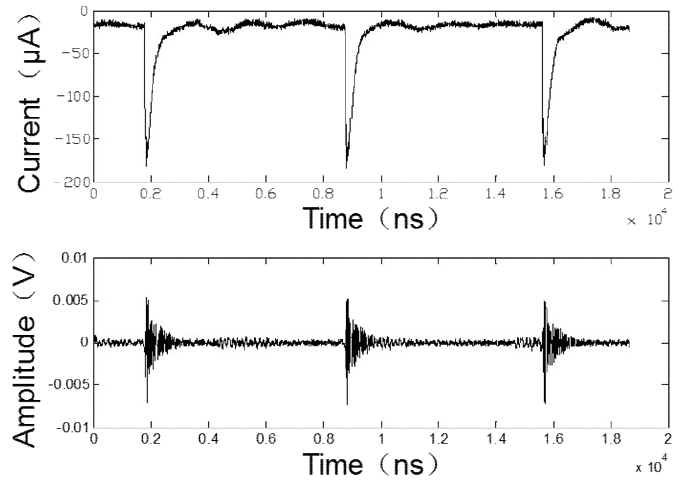
Figure 2. Trichel pulse current and its EM radiation signal.